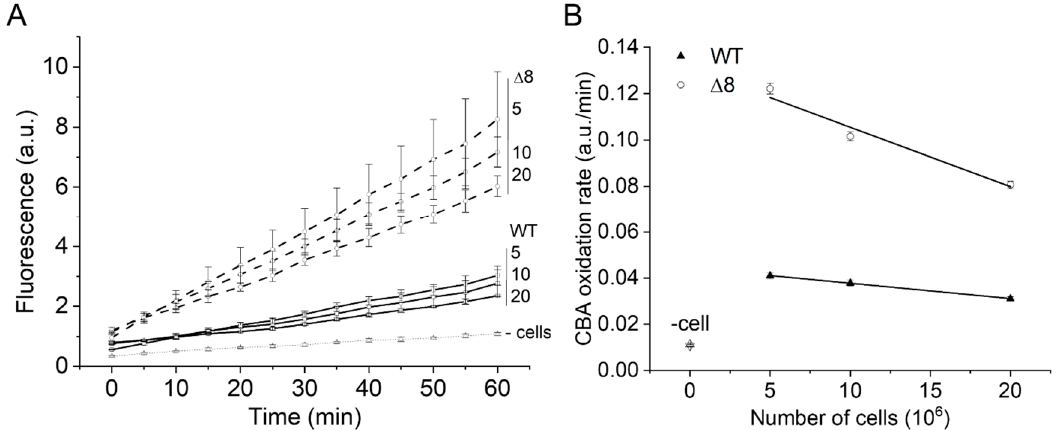
Figure 2. Effect of WT and Δ 8 S. cerevisiae cell density on CBA oxidation. Fluorescence traces of CBA oxidation ( A ) and CBA oxidation rate ( B ) by peroxynitrite fluxes with increasing cell densities. CBA (10 μ M), paraquat (10 μ M), and deta/NO (2,2 ′ -(hydroxynitrosohydrazono)bis-ethanimine; 500 μ M) were added to 96-well plates containing a different number of WT and Δ 8 S. cerevisiae cells per well (5, 10, and 20 × 10 6 ). The fluorescence measurements were initiated immediately after the PQ/NO • donor addition and were recorded every 5 min for 1 hour. The experimental conditions and fluorescence acquisition parameters are described in the Figure 1 legend. The experimental procedures were performed at least three times with similar results.